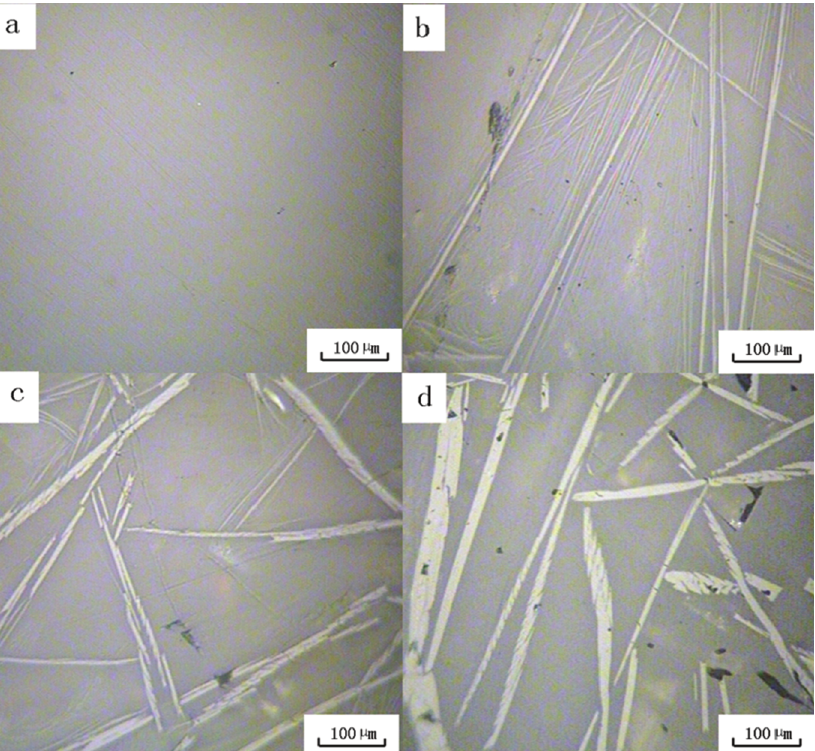
Figure 5: Optical microscopic of the quenched slag at 1,638 K with different times: (a) 0 min, (b) 20 min, (c) 60 min and (d) 120 min.